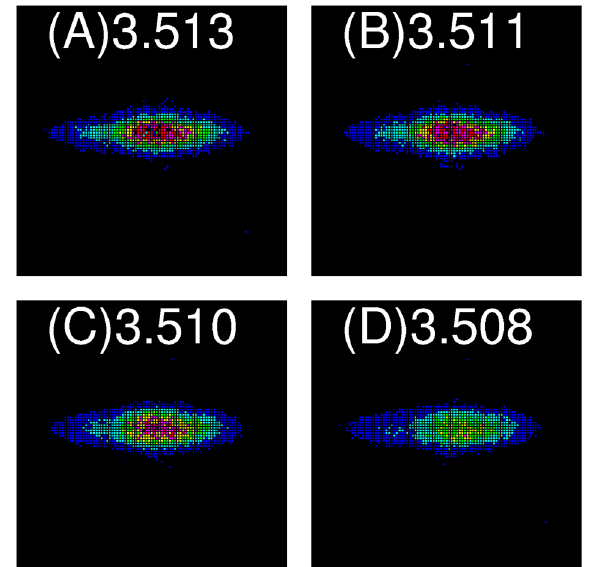
FIG. 4. (Color) Two-dimensional beam profile measured with the SBPM, for bare tunes (a) 3.513, (b) 3.511, (c) 3.510, and (d) 3.508, respectively.